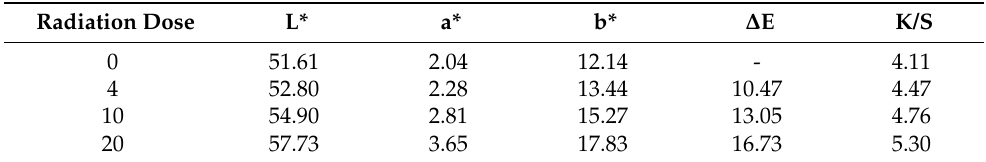
Table 1. CIELab coordinates (L*, a*, b*), ∆ E and K/S measurements for control and irradiated PVA/Ag + /NBT films from 4 to 20